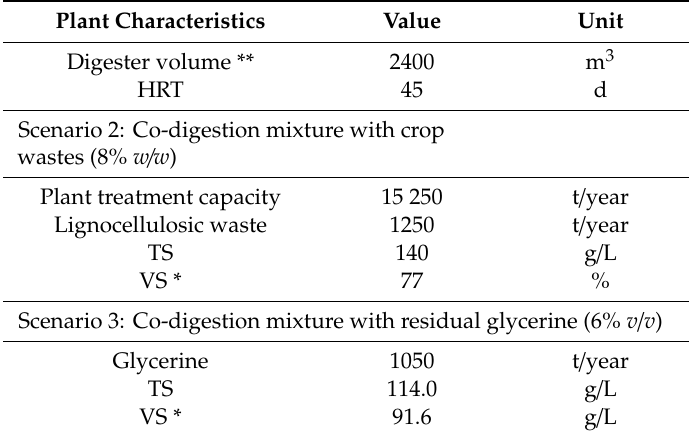
Table 1. Characteristics of the digestion reactor. Plant